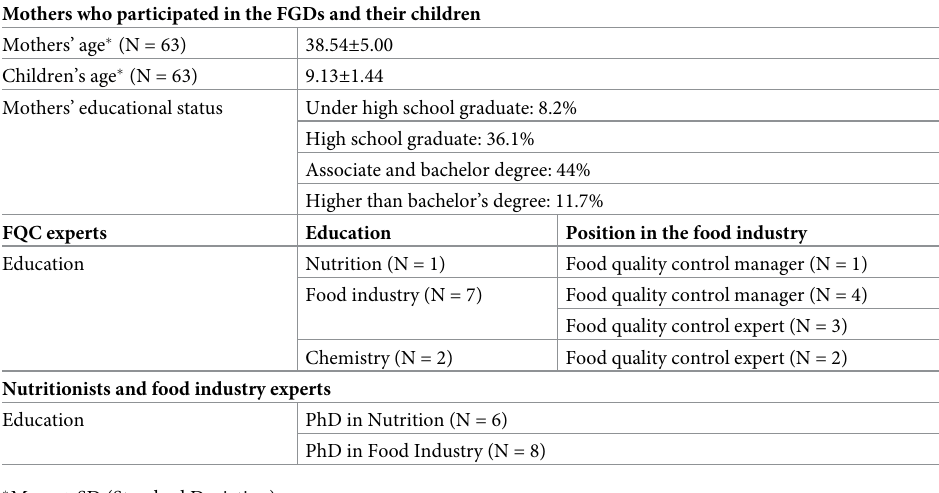
Table 1. Participants’ characteristics.